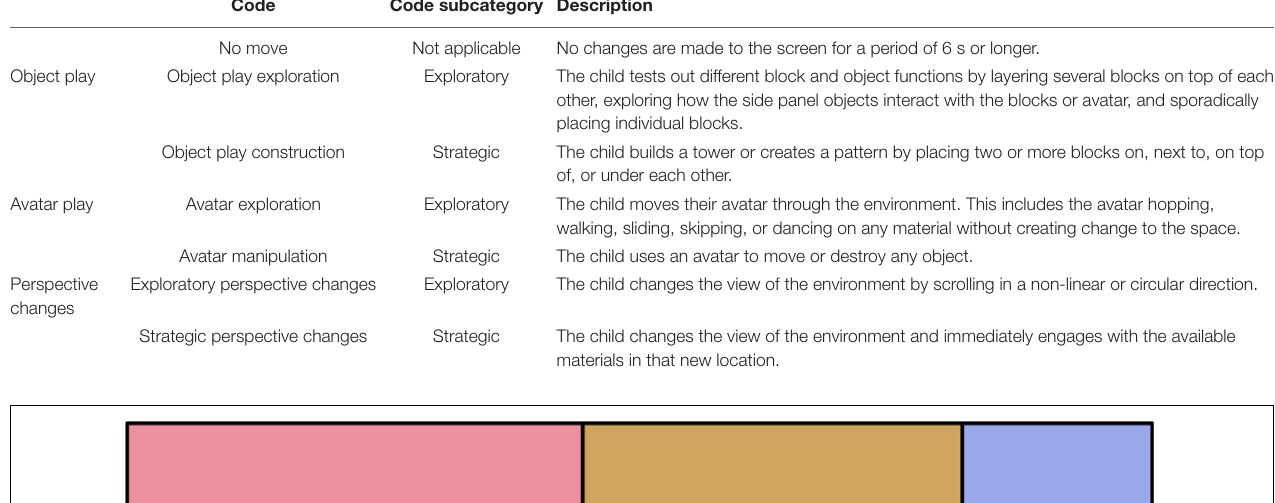
TABLE 1 | The coding scheme used to code children’s Toca Blocks play.